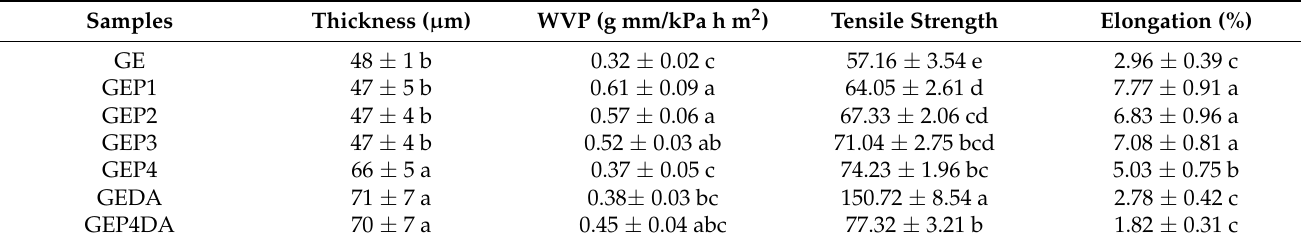
Table 2. Water vapor permeability, tensile strength, and elongation of the films.